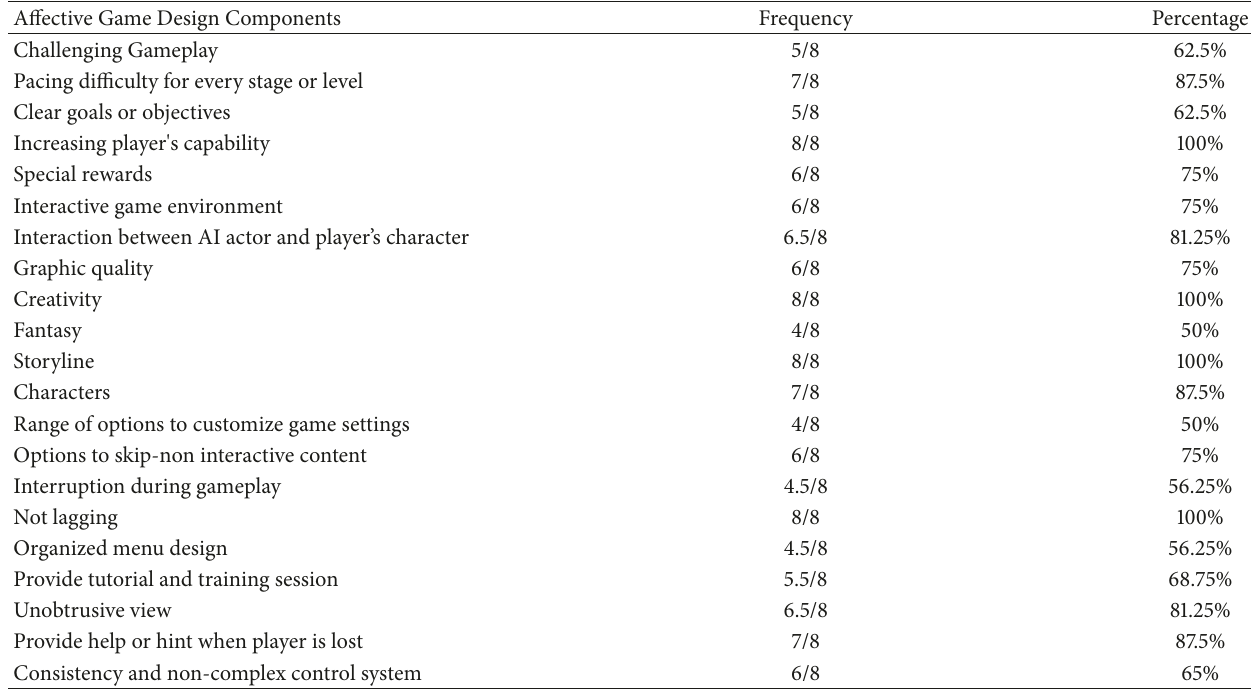
Table 1: Affective game design components that were aggregated from post literature